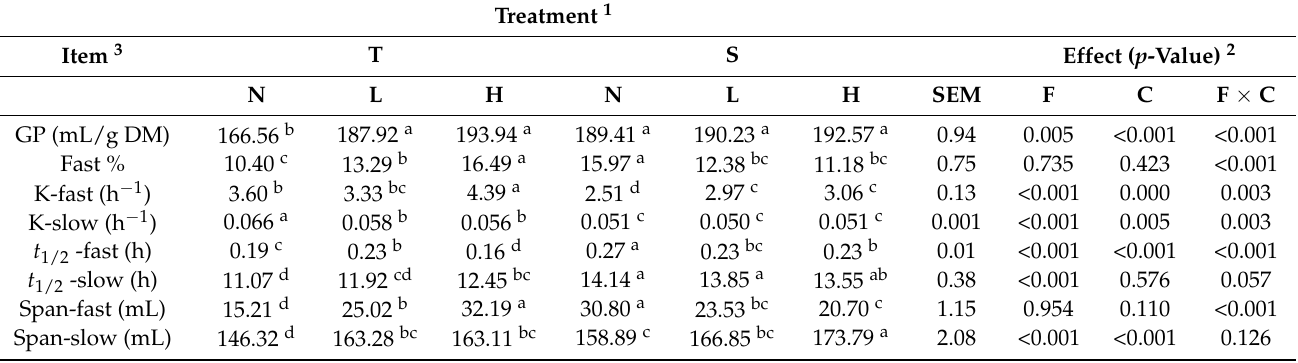
Table 4. The effect of M-CMS supplementation to diets with or without corn silage on the gas kinetic parameters (Experiment 1).